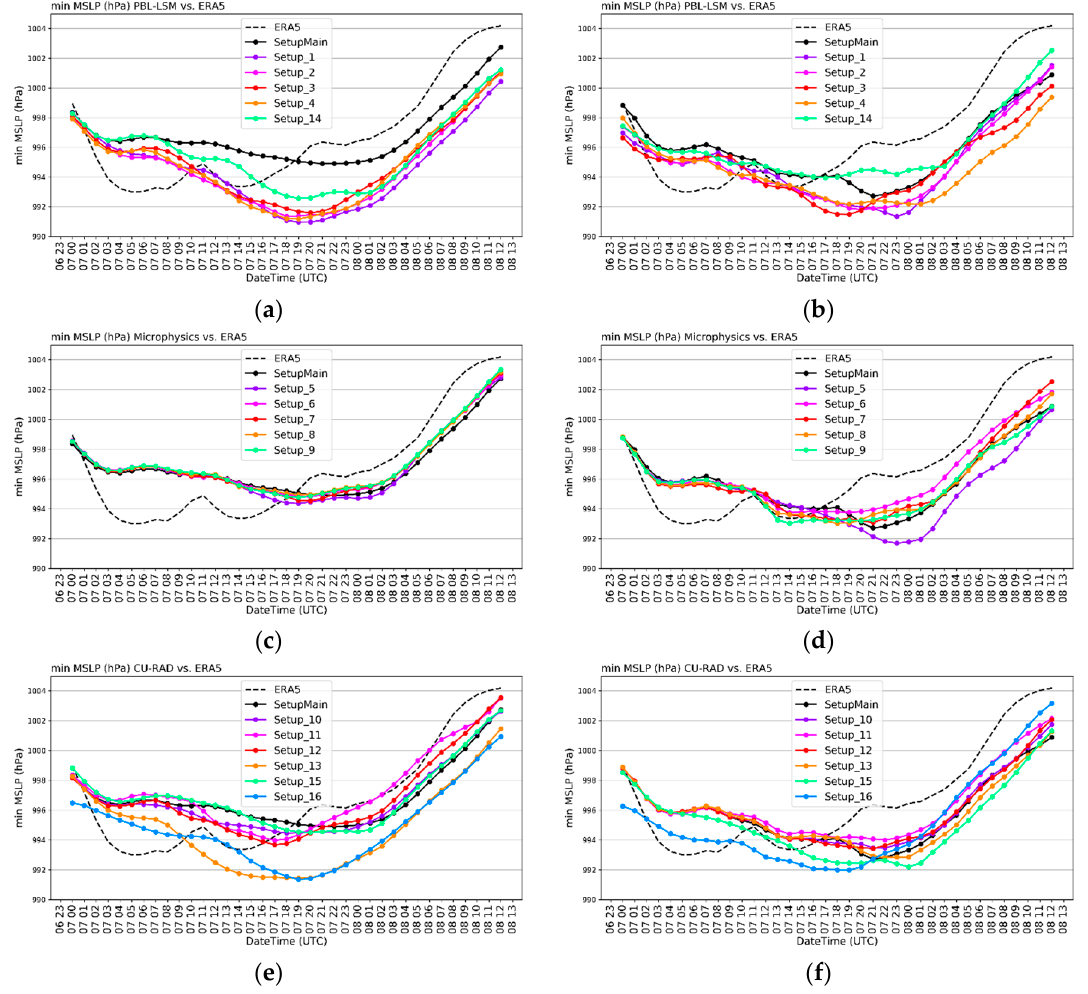
Figure 4. Minimum mean sea-level pressure (MSLP) of PBL/LSM simulations: ( a ) D01 (parent domain) and ( b ) D02 (nested domain), MP simulations: ( c ) D01 and ( d ) D02 and CU/RAD simulations: ( e ) D01 and ( f ) D02. The ERA5 (black dashed line) and control run (setup-MAIN–black solid line) are also shown. A cloud-free area corresponding to the “eye” is apparent in the satellite imagery before 12